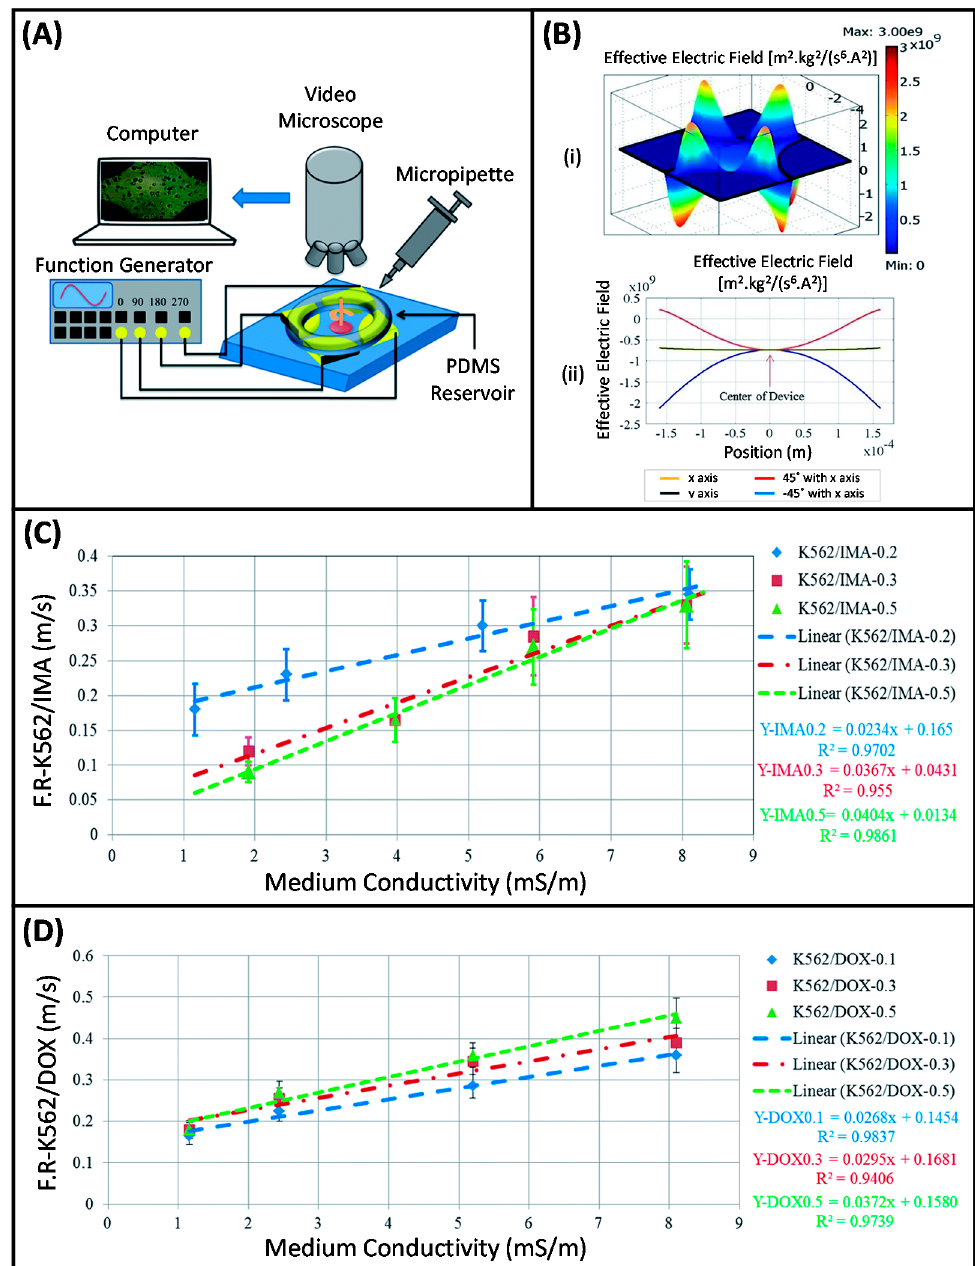
Figure 1. ( A ) The experimental setup for electrorotation (ER) tests. ( B ) Simulation results were performed to examine the effective electric field (EEF) distribution on the device surface. ( i ) Height representation of the EEF distribution. ( ii ) The variations of the EEF distribution along four lines passing through the electrode center. ( C ) Straight line fitted to the data points of the peak rotation frequency of K562/IMA cells and cell radius versus medium conductivity. ( D ) Straight line fitted to the data points of the peak rotation frequency of K562/DOX cells and cell radius versus medium conductivity. Reproduced from [160] with permission from The Royal Society of Chemistry.